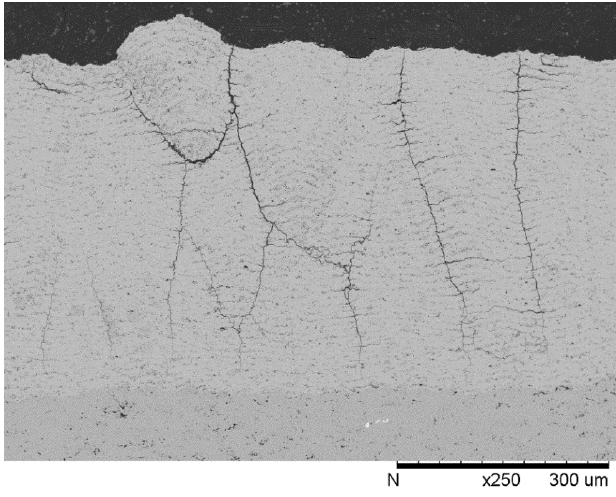
Figure 8. C2 coating, nano-suspension in